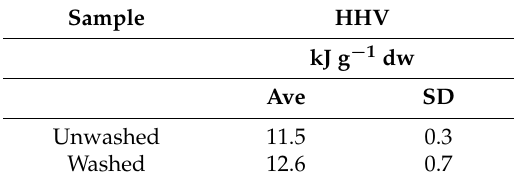
Table 4. The higher heating value of S. muticum before and after freshwater